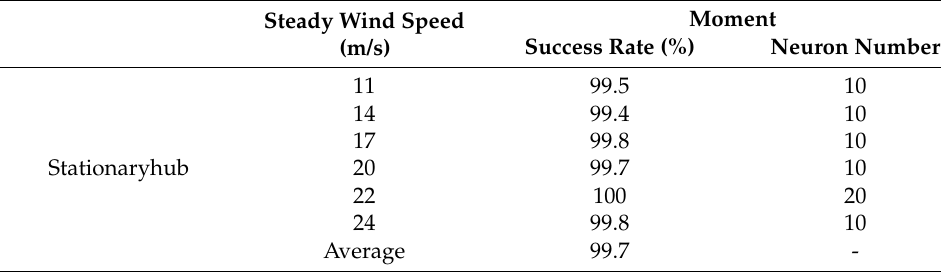
Figure 14. Confusion matrix for success rate ( M a , 20 m/s). Table 6. All confusion matrix for success